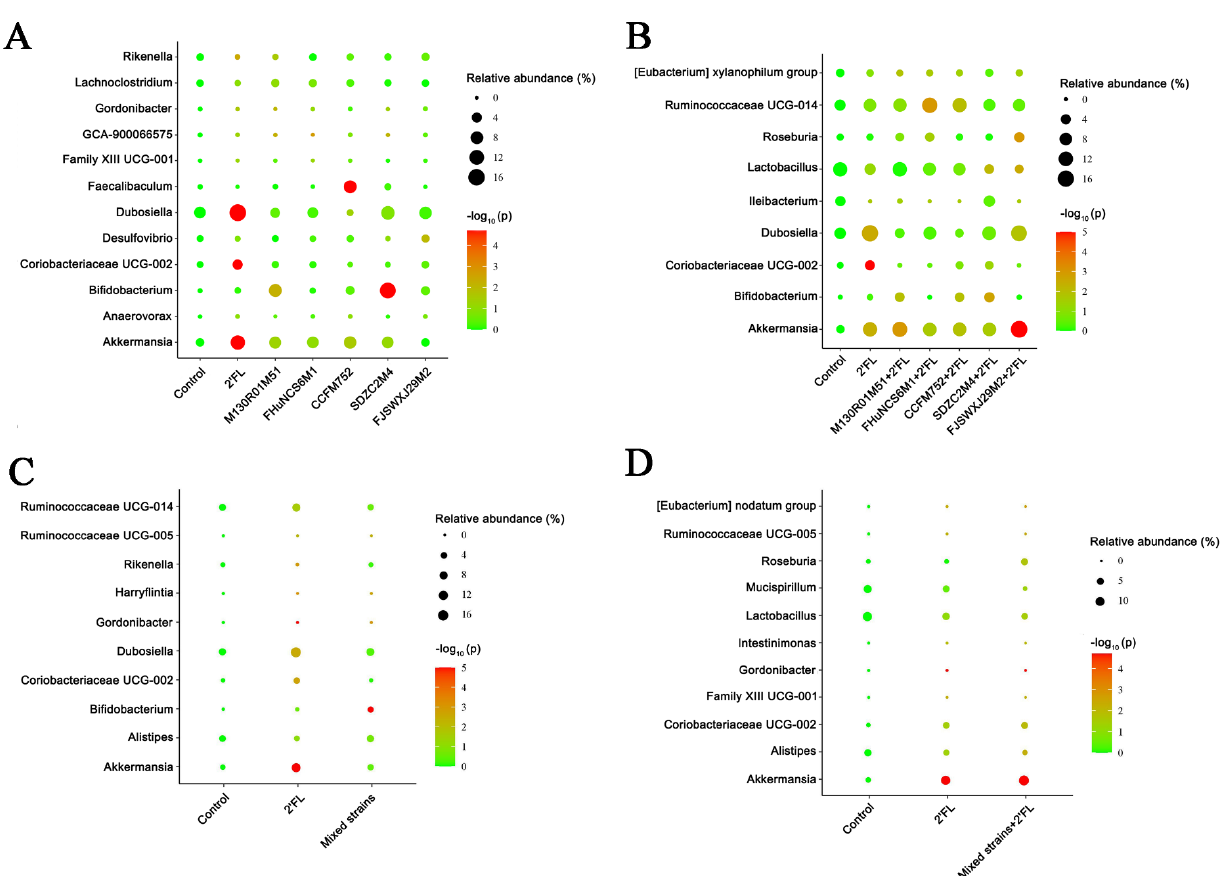
Figure 8. Differences in the abundance of genus levels of Bifidobacterium group ( A ), Bifidobacterium + 2 ′ FL group ( B ), mixed strains group ( C ), and mixed strains + 2 ′ FL group ( D ) (n = 8 for each group). The relative abundance of species of Bifidobacterium in the intestinal tract of mice was further analyzed. The results showed that the relative abundance of B. longum subsp. Infantis and B. bifidum was increased after the intragastric administration of mixed strains (Figure 9A). After the intragastric administration of mixed strains and 2 ′ FL, the balance between B. longum subsp. infantis and B. bifidum appeared to be different. The relative abundance of B. longum subsp. infantis was higher than that of B. bifidum (Figure 9B), which may have been due to the different metabolic modes and activities of 2 ′ FL between the two species.